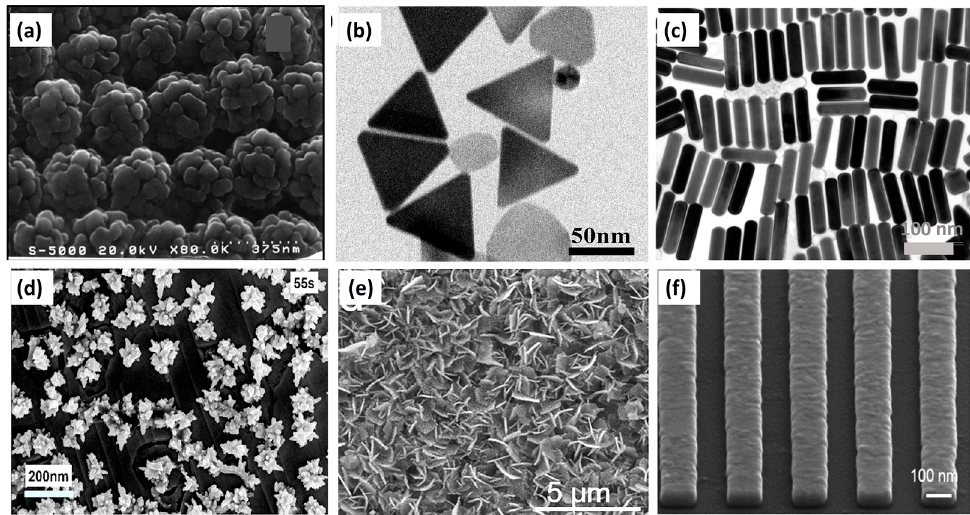
Figure 4. ( a ) SEM image of an ordered hollow Au/Ag nanostructured film. Reprinted from [89], with permission from ACS Publications. ( b ) TEM image of Ag triangular nanoplates. Reprinted from [90], with permission from Elsevier. ( c ) TEM image of Au nanorods (AuNRs). Reprinted from [91], with permission from ACS Publications. ( d ) SEM image of Ag nanoflowers (AgNFs)/Graphene/Copper (Cu). Reprinted from [92], with permission from Elsevier. ( e ) SEM image of Ag/WO 3-x nanoflakes. Reprinted from [93], with permission from Elsevier. ( f ) SEM image of Au nanostripes. Reproduced under the terms of CC BY licensed from [94].